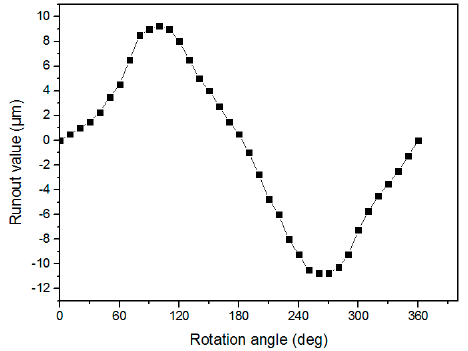
Figure 6. Measured coaxial error of the mandrel to the spindle.